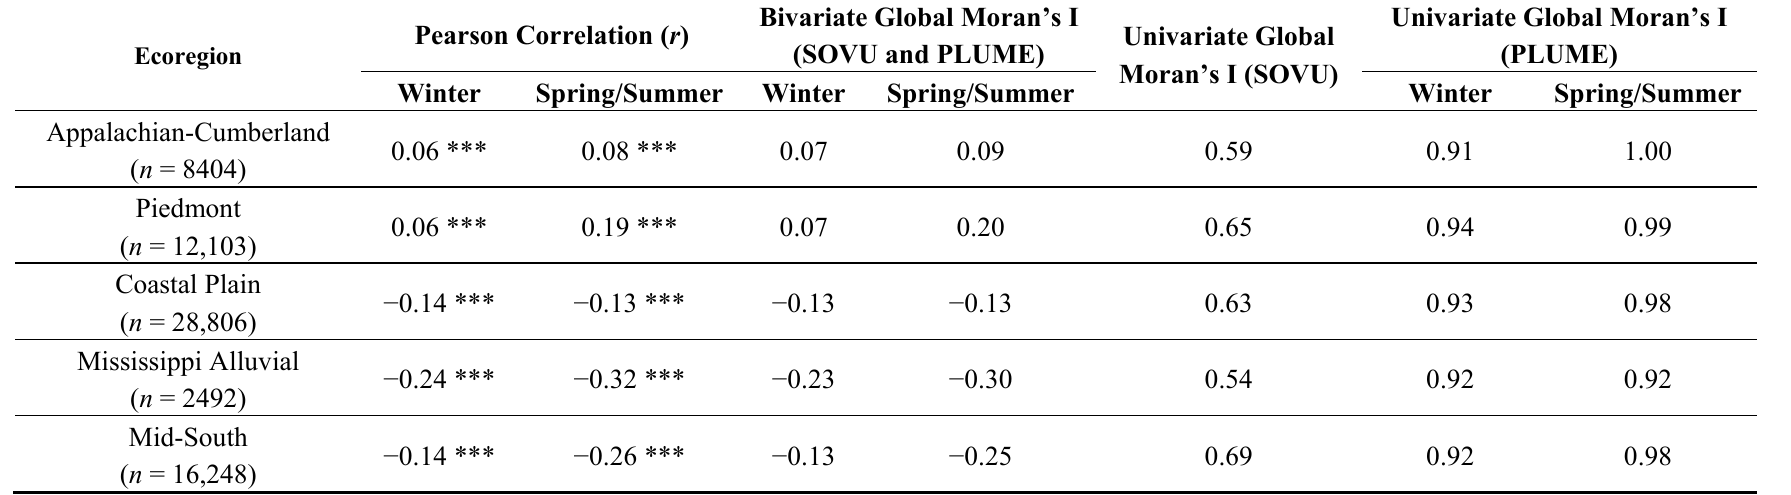
Table 3. Pearson correlations and bivariate and univariate global Moran’s I for SOVU and PLUME by ecoregion and season of year. Pearson Correlation ( r Ecoregion